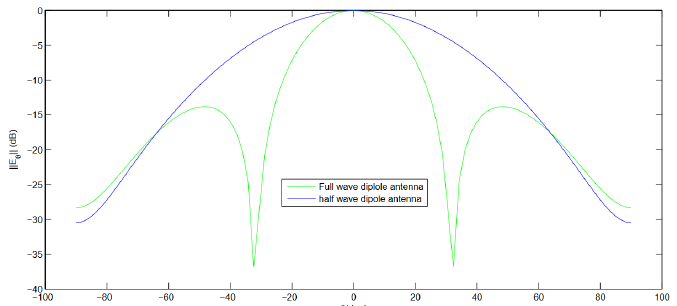
Figure 9. Radiation pattern calculated using the MoM-GEC method for a half-wave and full- wave dipole antenna: f = 5.4 GHz, α 0 = 0 rad m − 1 , β 0 = 0 rad m − 1 , w = 1 mm, δ = 0.75 mm ( w (cid:28) λ (cid:28) λ ) , d x = 108 mm, d y = 108 mm. ( Blue color ) L = λ 0 0 , δ 0 L = λ 0 ≈ 54 mm, h = 1.25 mm, and (cid:101) = (cid:101) r = 1 (air).